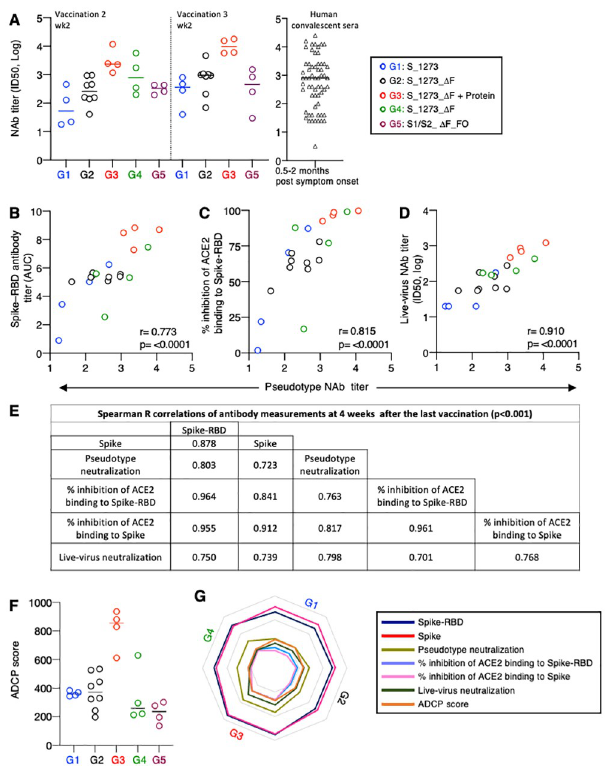
Fig 2. Spike-antibody effector functions. Neutralization assays were performed using Spike-1254 (Wuhan-Hu-1) pseudotyped reporter virus in HEK293/ACE2 wt cells. ( A ) NAb titers (ID50) measured in the different vaccine groups at 2 weeks after the 2 nd and the 3 rd vaccination were compared to NAb titers obtained in SARS-CoV-2 convalescent sera (N = 48) collected 0.5 to 2 months post symptom onset. The same in-house pseudotype NAb assay was used. Median values are indicated. ( B-D ) Spearman correlations of reciprocal pseudotype NAb titers (ID50, log) and ( B ) Spike-RBD antibody titers (ELISA, AUC); ( C ) % inhibition of ACE2 binding to Spike-RBD; ( D ) reciprocal live-virus neutralization ID50 (PRNT, log) using sera collected 2 weeks after the last vaccination. ( E ) Summary of Spearman correlations of antibody measurements 4 weeks after the last vaccination determined at one week before challenge. ( F ) Antibody-dependent cellular phagocytosis (ADCP) score is shown for the 4 vaccine groups at 4 weeks after the last vaccination. ( G ) Radar plot summarizing the serologic features.